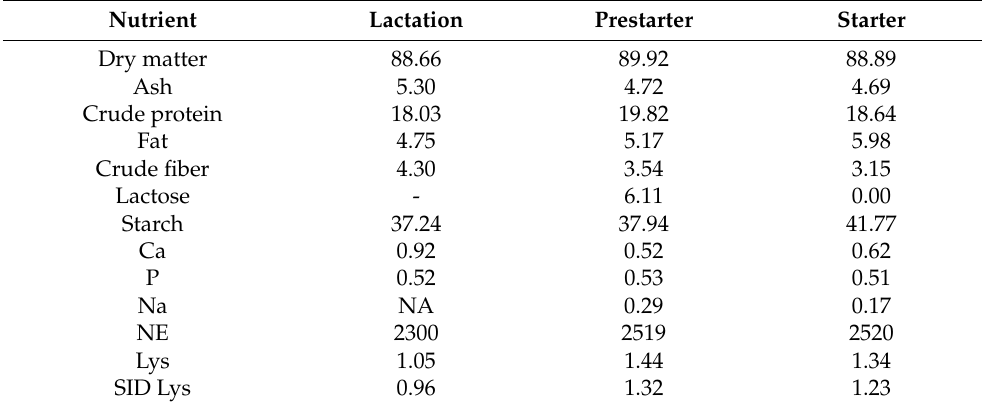
Table 2. Calculated nutritional composition of the control experimental diets (%, as fed). Nutrient Lactation Prestarter Starter Dry matter